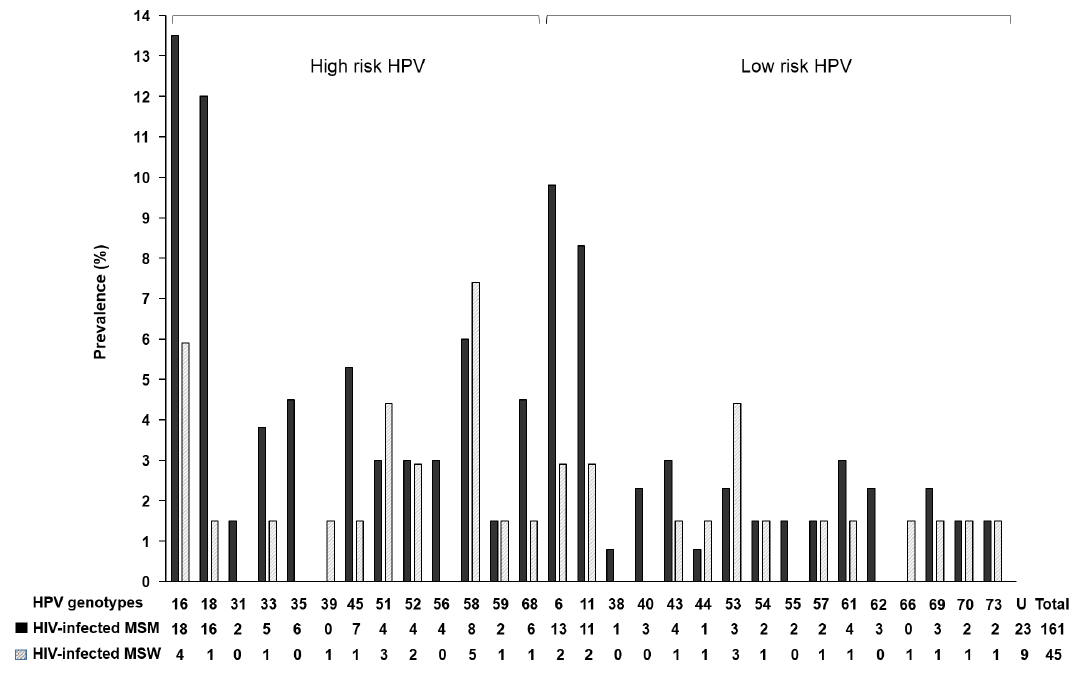
Fig 1. Human papillomavirus (HPV) genotypic distribution among HIV-infected Men who have sex with men and among HIV-infected men who have sex with women. (MSM, men who have sex with men; MSW, men who have sex with women; U, untypeable)